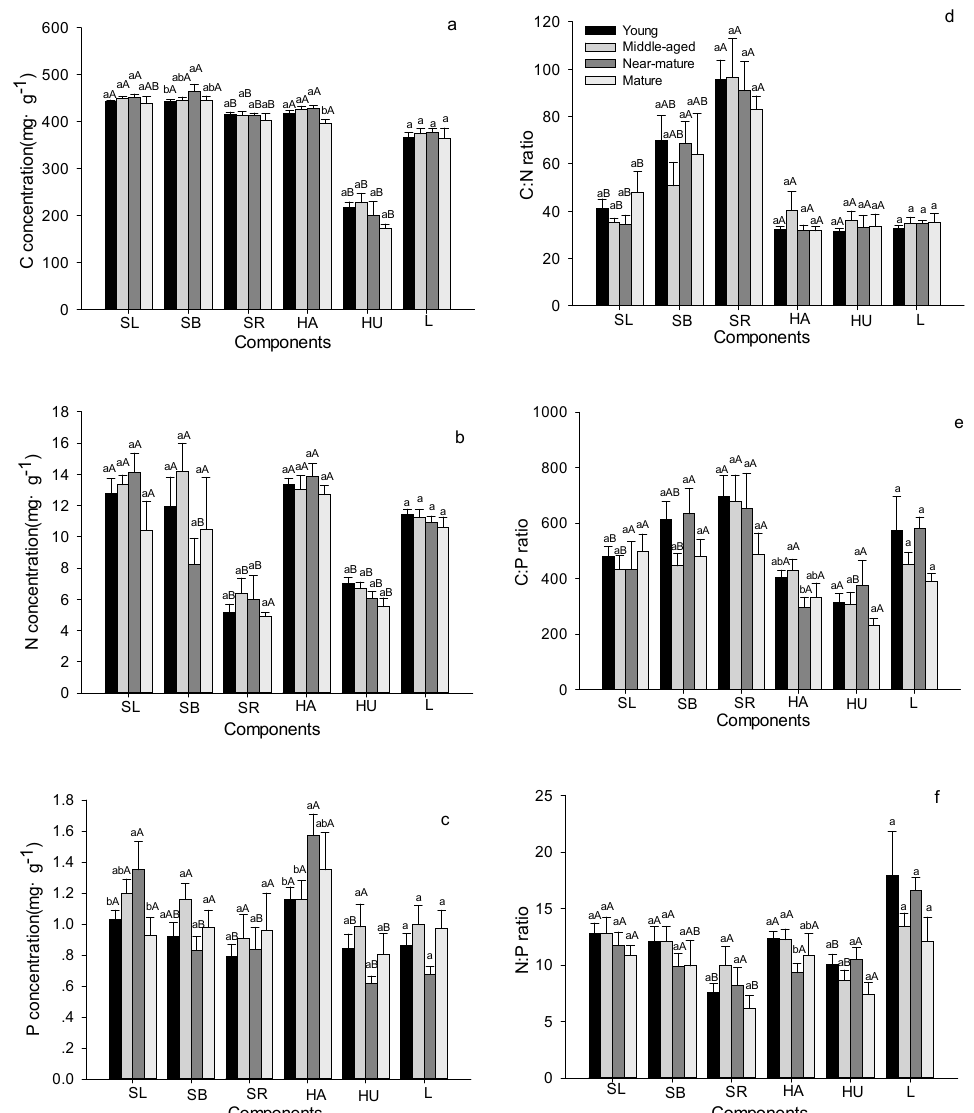
Figure 3. C, N, and P stoichiometric characteristics in shrub, herb and litter layers in Quercus variabilis natural secondary forest of different age classes (Means ± SE, n = 8, 6, 3 and 3 for young, middle-aged, near-mature and mature stands, respectively). ( a ) C concentration in shrub, herb and litter layers of different age classes; ( b ) N concentration in shrub, herb and litter layers of different age classes; ( c ) P concentration in shrub, herb and litter layers of different age classes; ( d ) C:N ratio in shrub, herb and litter layers of different age classes; ( e ) C:P ratio in shrub, herb and litter layers of different age classes; ( f ) N:P ratio in shrub, herb and litter layers of different age classes. Different small letters indicated significant difference in the same indicators among age classes, and different capital letters indicated significant difference among different components in SL, SB, SR or in HA, HU in the same forest age class ( p < 0.05). SL: shrub leaf, SB: shrub branch, SR: shrub roots, HA: herbage aboveground, HU: herbage underground, L: litter.